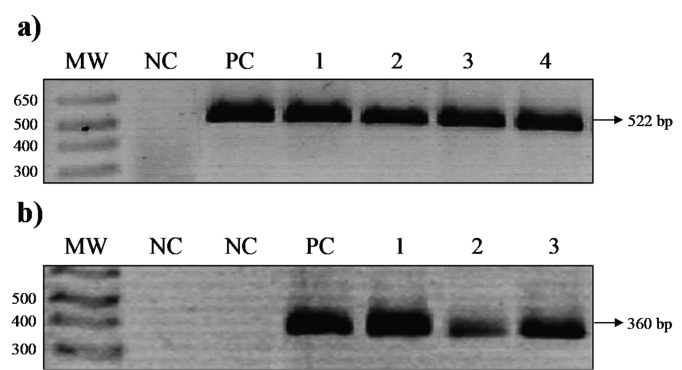
Agarose gel electrophoresis of PCR products. Representative gel electrophoresis of PCR products of (a) 16S rRNA and (b) cagPAI empty site. (a) Lanes: MW, 100 bp molecular weight marker; NC, negative control; PC, positive control (H. pylori strain ATCC43504); 1-4, isolated H. pylori strains. (b) Lanes: MW, 100 bp molecular weight marker; NC, negative controls (second lane: H. pylori strain ATCC43504 vacAs1m1/cagA+/babA2+); PC, positive control (strain UEGE844 vacAs2m2/cagA-/babA2-); 1-3, isolated H. pylori cagA- strains.